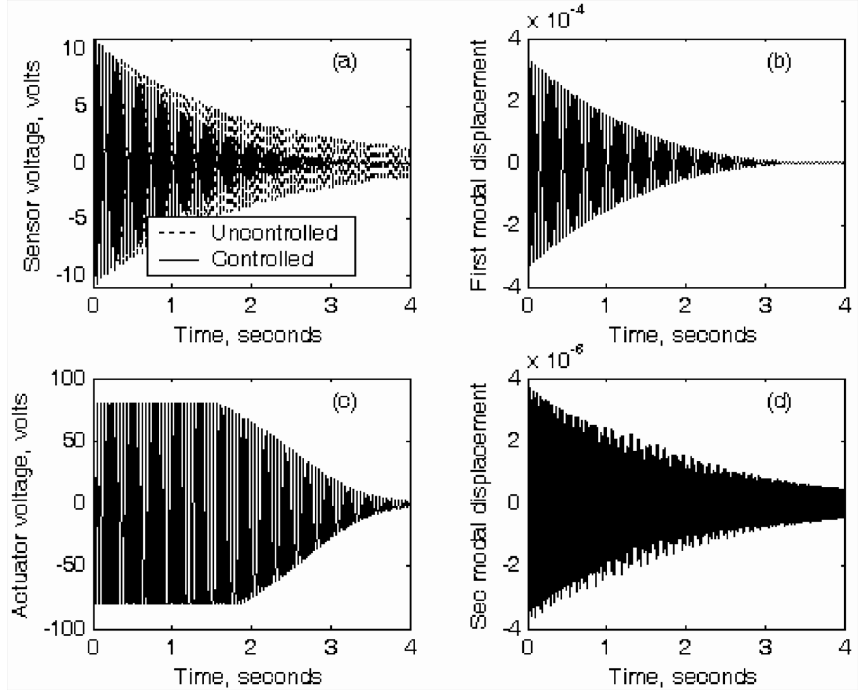
Fig. 8. SMC with fuzzy logic (a) sensor voltage, (b) first modal displacement, (c) actuator voltage and (d) second modal